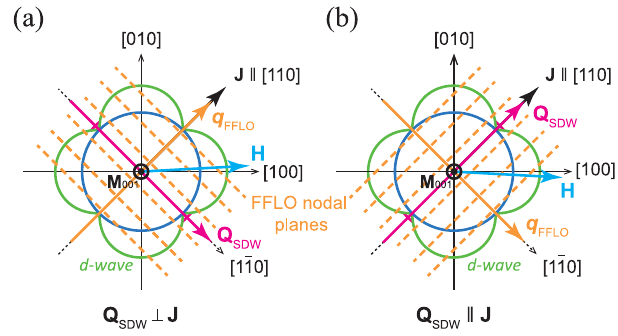
FIG. 7. Possible configuration of a FFLO state in CeCoIn 5 . Schematic of the d -wave and the FFLO order parameters, the Q vector, and the magnetic-field directions that are compat- SDW ible with both hypersensitivity and thermal conductivity within a modified version of the FFLO scenario [29]. This modification would require that q be forced to lie along the nodes of the d FFLO wave, instead of always being parallel to the applied magnetic field. Dashed lines indicate the nodes of the FFLO state with normal quasiparticles. (a) FFLO nodal planes increase scattering and reduce thermal conductivity when they are perpendicular to J . (b) The nodal planes contribute to thermal transport along J when they are parallel to